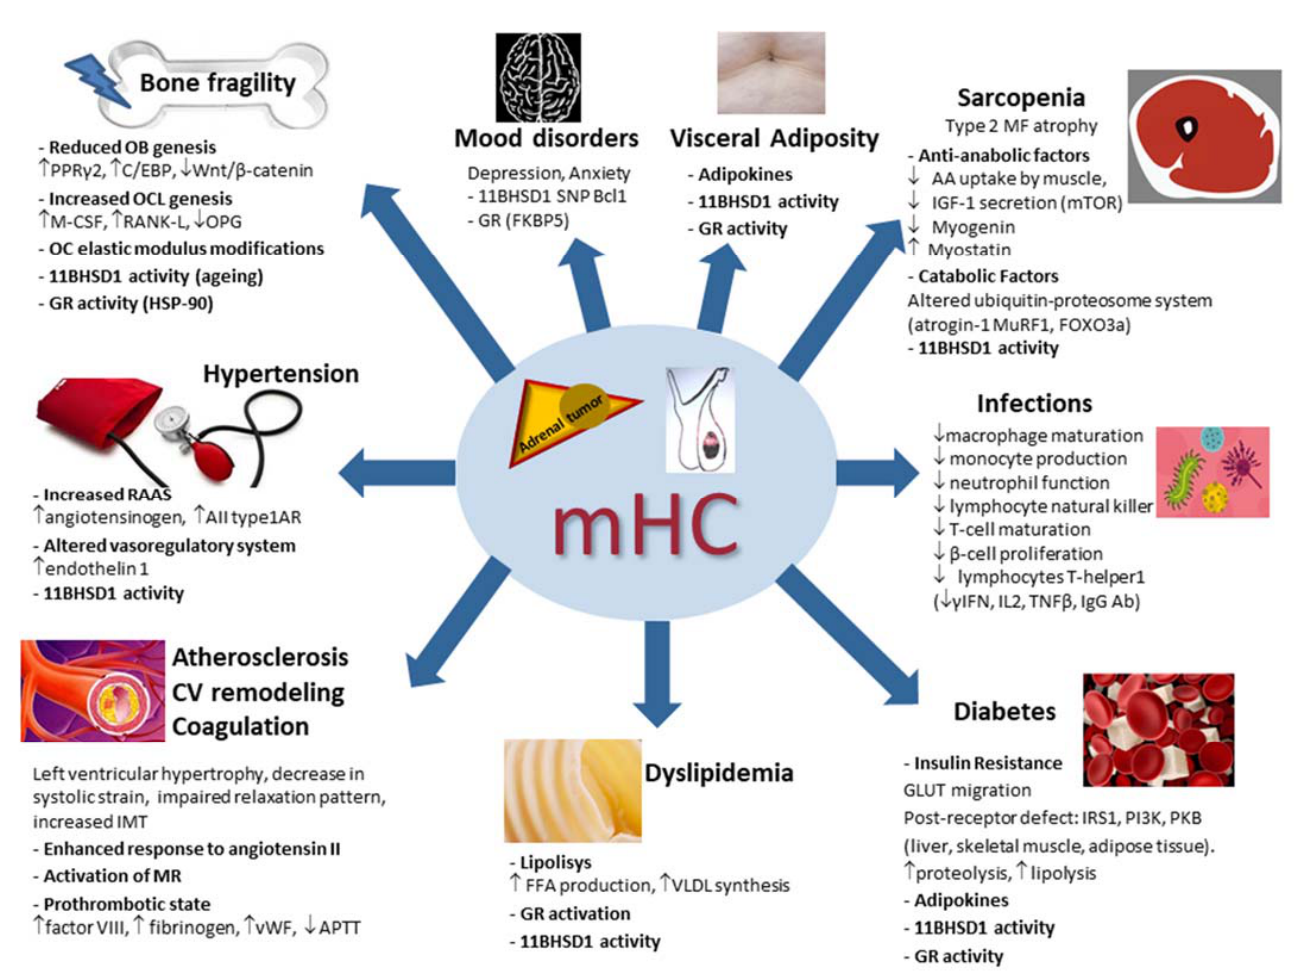
Figure 2. Main pathophysiologic mechanisms of the systemic consequences of mild hypercortisolism. mHC: mild hypercortisolism; OB: osteoblast; OCL: osteoclast; OC: osteocytes; PPR γ